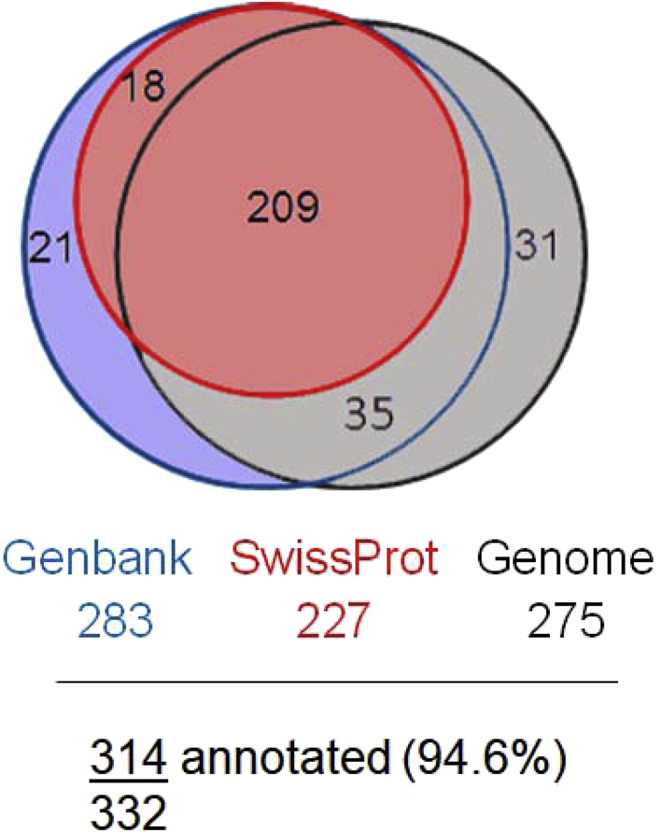
Annotation to different databases of the 332 genes found to be ≥ 2-fold differentially expressed. Venn diagrams indicate the number of genes with a significant match to the sea bass genome, Swiss-Prot protein database or GeneBank protein database, the number of genes annotated by more than one database are inside the intersecting areas. The annotation was carried out in order of preference; 1) matches to Swiss-Prot, 2) matches to the sea bass genome and 3) Genbank matches as indicated by the colour shading. The areas of each sphere are proportional to the number of genes annotated.